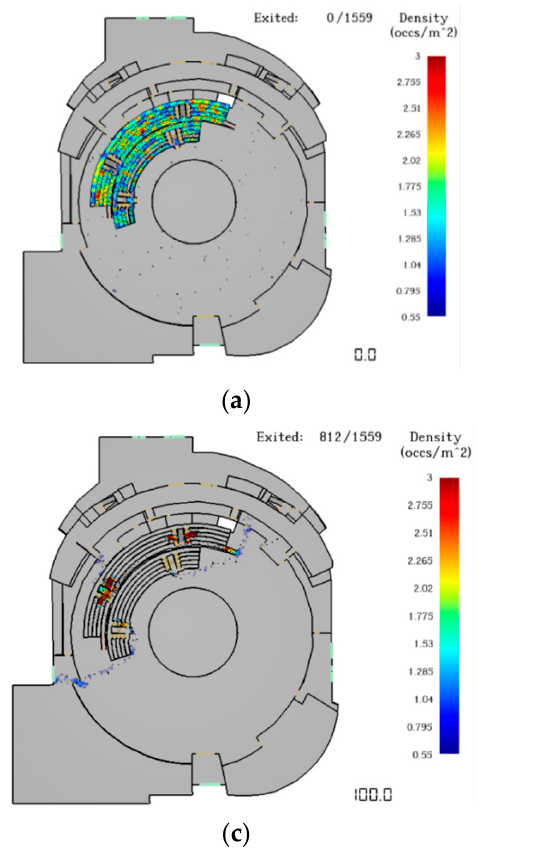
Figure 21. Evacuation process and density distribution of the occupants on the first floor after adding emergency evacuation stairs. ( a ) Occupant density at 0 s; ( b ) occupant density at 50 s; ( c ) occupant density at 100 s; ( d ) occupant density at 234.3 s.